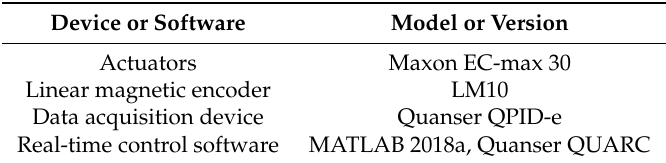
Figure 9. The practical platform of proposed teleoperation system. Table 2. Device models and software